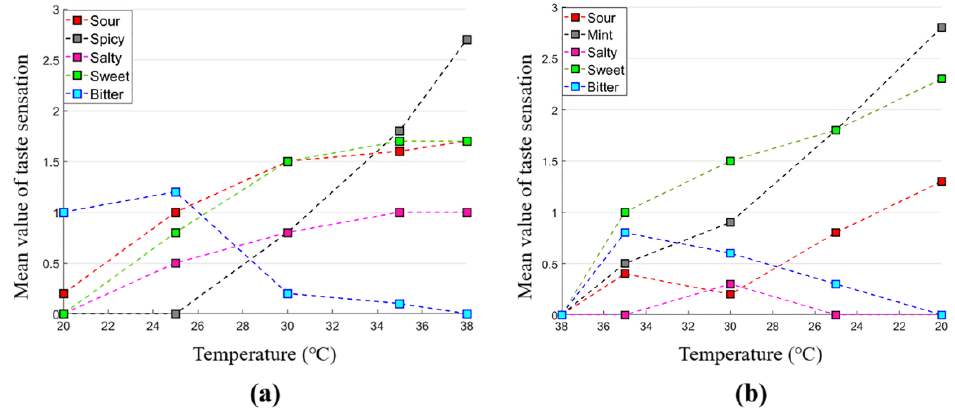
Figure 4. Thermal stimulation ( a ) heating up to 38 °C ( b ) cooling down up to 30 °C.